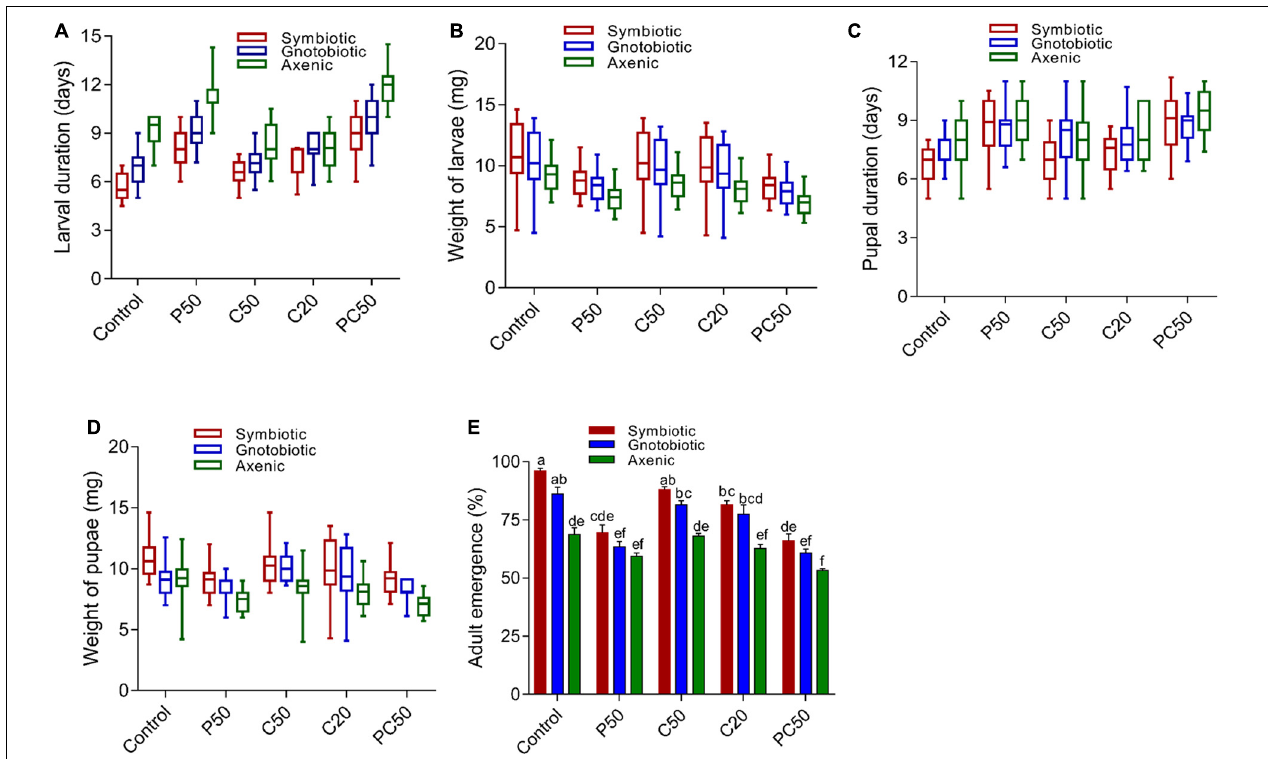
FIGURE 1 | Effect of diet and gut bacterial manipulation on the development of B. dorsalis larvae: larval development duration (A) , larval weight (B) , pupal development duration (C) , pupal weight (D) , and adult eclosion rate (E) .